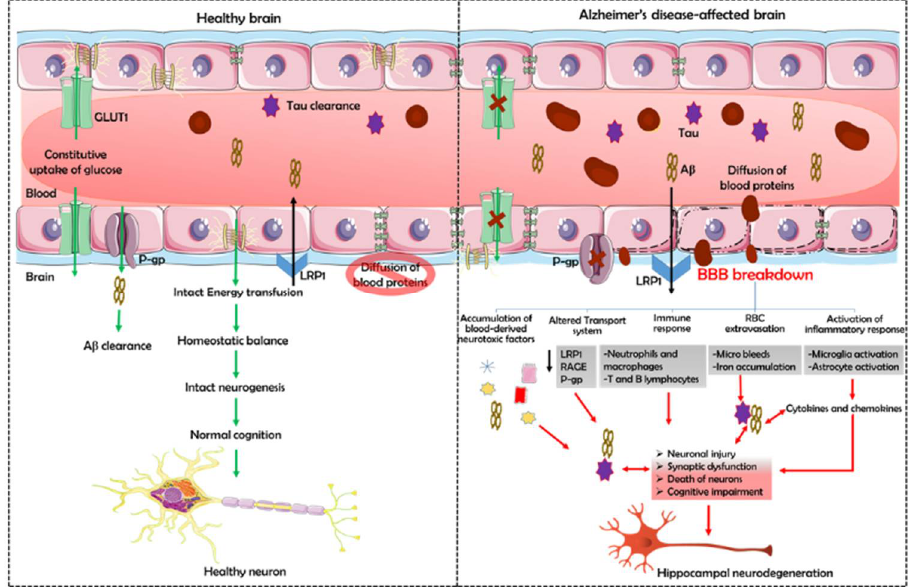
Figure 2. The blood–brain barrier in healthy and Alzheimer’s disease-affected brains. Tight junc- tion protein disruption, decreased transport function, increased permeability, pericyte degradation, and accumulation of toxic substances such as Aβ and tau due to impaired clearance disrupt the BBB. These events cause an accumulation of neurotoxic hemoglobin and iron in the brain, increasing ROS production and oxidative stress in neurons. Neuronal toxic blood-derived proteins, such as fibrinogen, thrombin, and plasminogen, degrade the neuronal extracellular matrix, resulting in cell death and detaching neurons. This activates microglia and promotes neuroinflammation. BBB failure can also abolish the immune privilege, leading to the production of anti-brain antibodies directed against various axonal and membrane components of neurons.